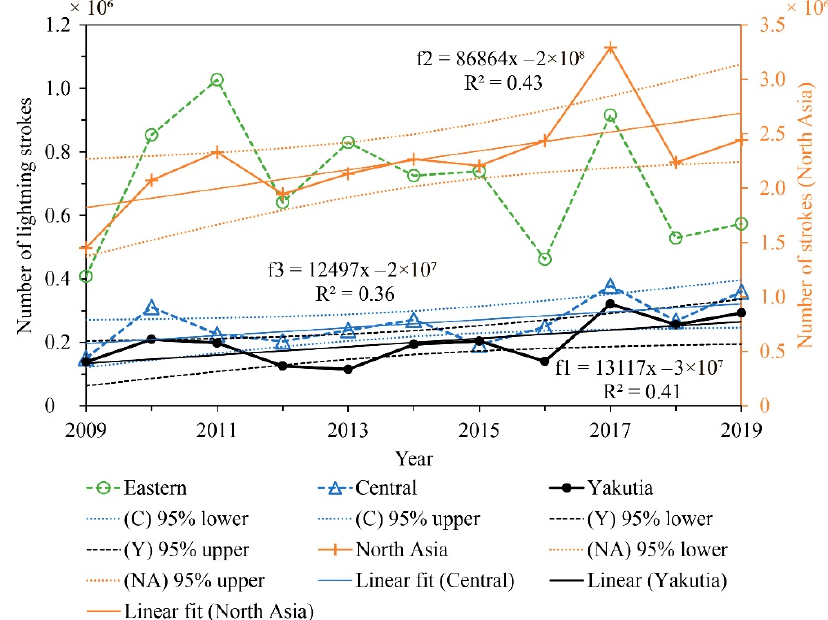
Figure 3. Lightning stroke number and linear fit (f1, f2, f3 functions) for the variations, obtained by